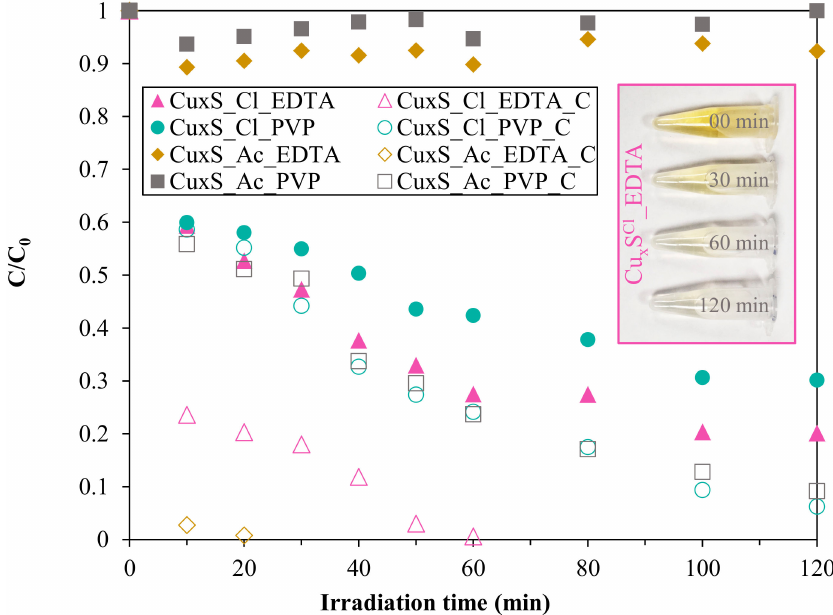
Figure 6. Photodegradation results with the Cu x S semiconductors under Vis light using methyl-orange as a model